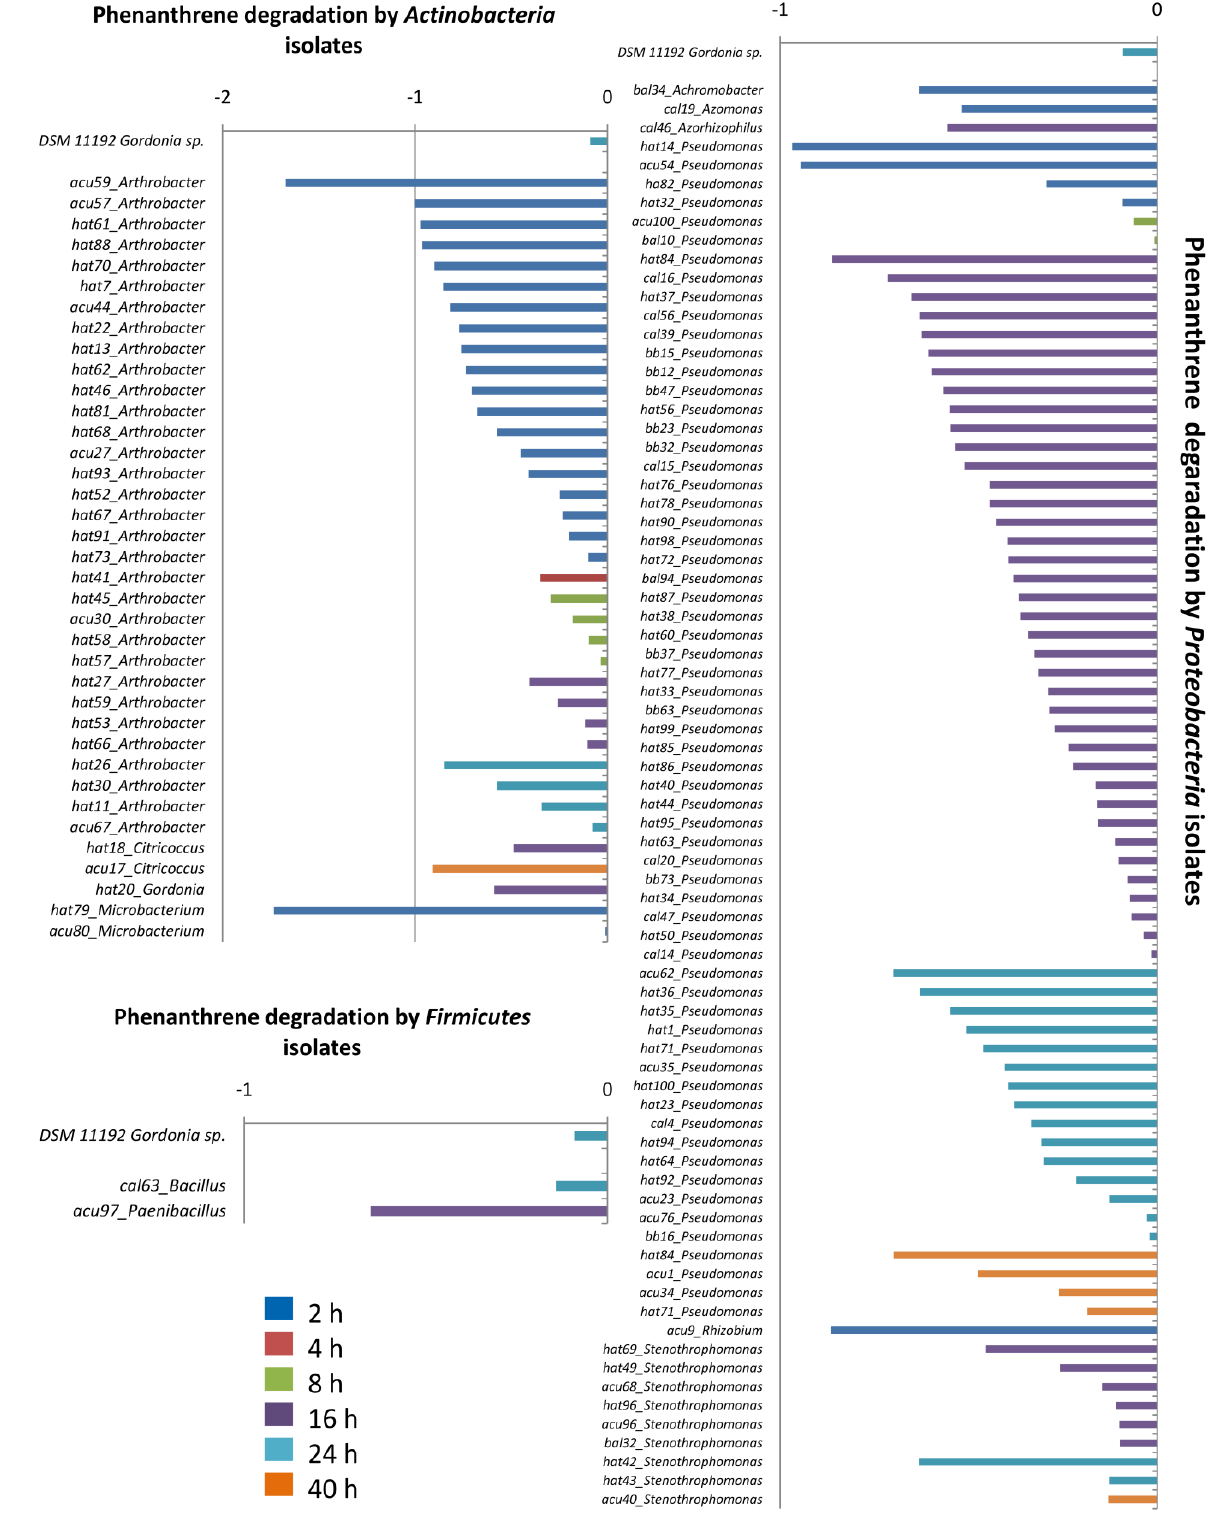
Figure 3. Visualization of the isolates based on their identification of the genus within phyla for the degradation of 0.05% of phenanthrene after ( a ) 2 h; ( b ) 4 h; ( c ) 8 h; ( d ) 16 h; ( e ) 24 h; and ( f ) 40 h; measured at 620 nm. Negative data indicate degradation. The positive control is at the top of the figure, and the genus of each isolate is shown. Each colored bar indicates the time of degradation for a determined degradation